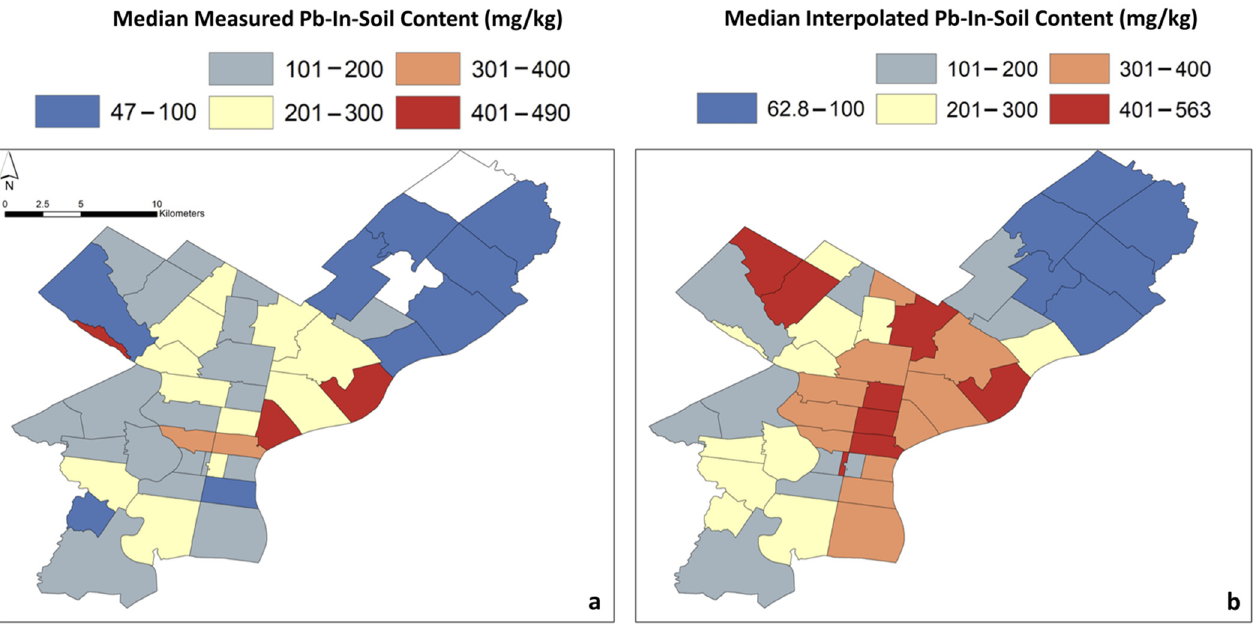
Figure 4. Map of Philadelphia displaying the median measured Pb-in-soil content in each ZIP-code area ( a ) and median interpolated Pb-in-soil content ( b ). The white ZIP-code areas in the left image were the result of zero soil samples with no interpolation taking place.